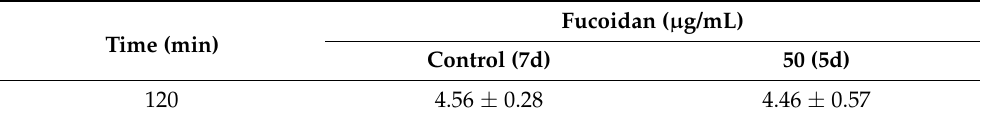
Table 4. Differences in the Papp of FITC-dextran absorption ( × 10 − 5 cm/s).